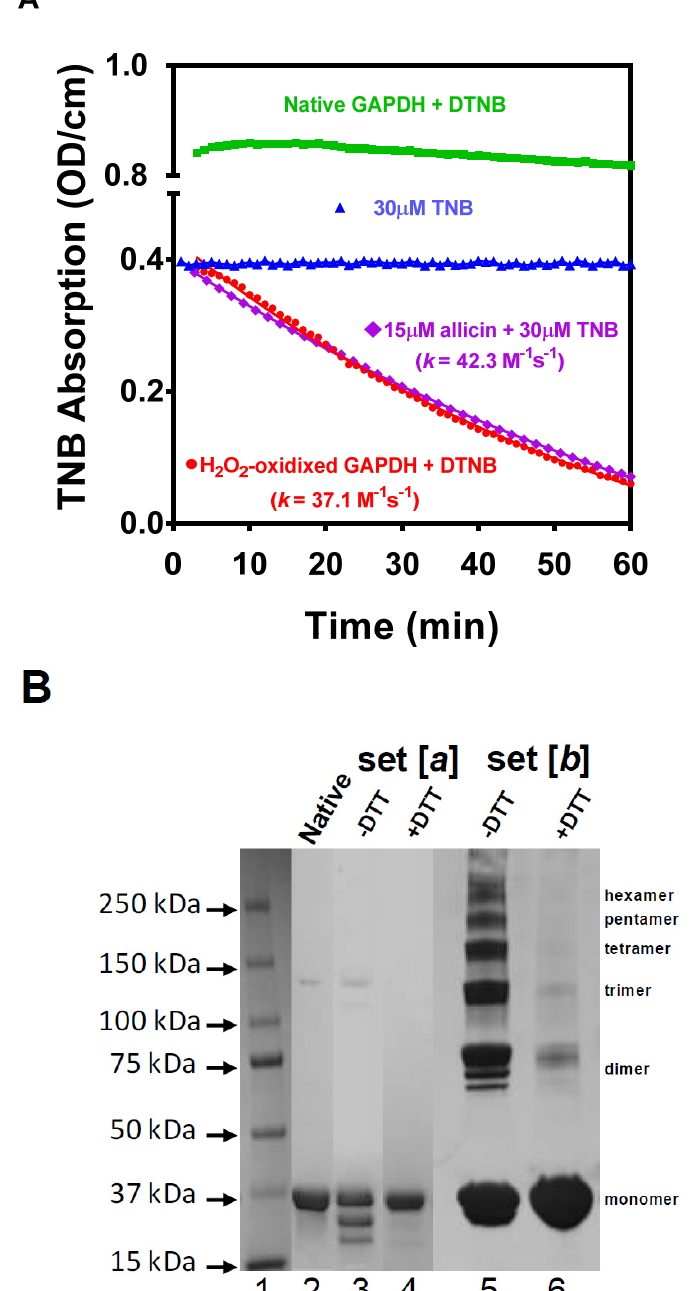
Figure 2. ( A , B ) Evidence for thiosulfinic ester and disulfide formation after H 2 O 2 oxidation of GAPDH. ( A ) Kinetics of TNB absorption of native and H 2 O 2 − oxidized r − GAPDH [3.8 nmol/mL] rapidly denatured in the presence of DTNB and 0.1% at RT. TNB released after DTNB oxidation was relatively stable over time (~16 mol TNB/mol GAPDH), as was a control sample of TNB added to the buffer. In contrast, TNB released after DTNB oxidation in H 2 O 2 − oxidized r − GAPDH declined over time. Similar kinetics for TNB consumption was observed for admixed TNB and allicin, (2:1 mol/mol). The stoichiometry and kinetic data were used to calculate the bimolecular rate constants for H 2 O 2 − oxidized r − GAPDH and allicin demonstrating that the data are consistent with the presence of thiosulfinic esters in the H 2 O 2 − oxidized enzyme. ( B ) The digital SDS − polyacrylamide gel electrophoresis (PAGE) composite figure was constructed by interleaving lanes from different unreduced and reduced gels. (L1) molecular weight markers. (L2) native r − GAPDH. (L3, and L4) un- reduced and reduced H 2 O 2 − oxidized r − GAPDH incubated post − oxidation for 2 h showing the pres- ence of DTT − sensitive gel − shifted banding mobility of >~36 kDa, due to intrasubunit disul fi de bond- ing. (L5 and L6) unreduced and reduced H 2 O 2 − oxidized r − GAPDH after denaturation and overnight incubation at pH 8.2, proving the presence of disul fi de − linked subunit multimers. The data show evidence for the formation of an intrasubunit disulfide bond formation after incubation of the oxi- dized enzyme, which equilibrates at mildly alkaline conditions to form DTT − sensitive intrasubunit multimers. Measurement of the bimolecular rate constant for TNB reaction with thiosulfinic es- ter from TNB absorption requires an accurate determination of the stoichiometry of total bound cysteinylthionitrobenzoate (see Materials and Methods and Supplementary Scheme SI for details). After a total of 3 h additional time of incubation a total of 16.6 ± 0.2 and 15.2 ± 0.3 ( n = 4) mol TNB/mol were recovered from native and H 2 O 2 − oxidized r − GAPDH, respectively. From the data and stoichiometry, a bimolecular rate constant of 42.3 M − 1 s − 1 was calculated for TNB reacting with the oxidized enzyme. These results are consistent with a mechanism whereby H 2 O 2 oxidizes C c (SH) and C v (SH) to a thiosulfinic ester in all subunits of the GAPDH homotetramer followed by reaction of the thiosulfinic ester with all inter/intra downstream cysteines forming eight mol disulfides/mol GAPDH. These results became progressively less reproducible with time if the H 2 O 2 − oxidized enzyme at 14 °C was not immediately denatured but allowed to incubate for a further 5– 20 min at 14 °C prior to denaturation in the DTNB buffer. The following experiments were conducted to investigate this discrepancy. Samples of native and H 2 O 2 − oxidized